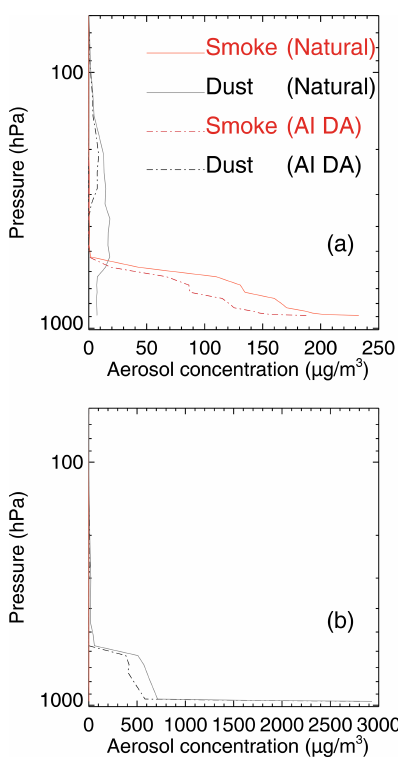
Figure 7. (a) Vertical distributions of smoke and dust aerosol con- centrations over 9.5 ◦ S and 20.5 ◦ E at 12:00Z on 28 July 2007 for both natural and AI-DA runs. (b) Similar to (a) but over 25.5 ◦ N and 12.5 ◦